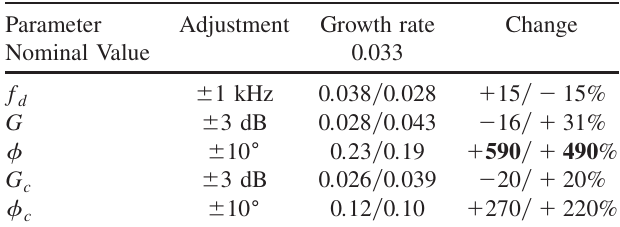
TABLE V. Growth rate sensitivity on LLRF parameters.